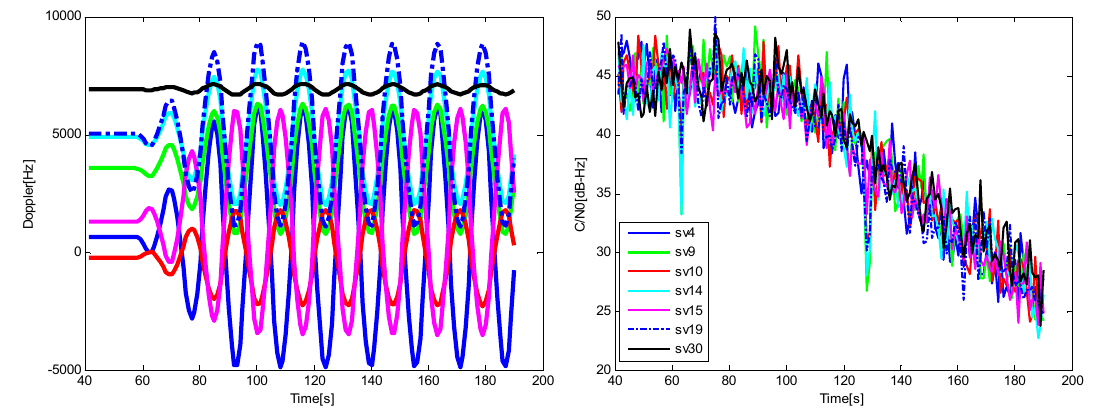
Figure 22. The Doppler ( left ) and C / N 0 for satellites ( right ) in Trajectory 2.